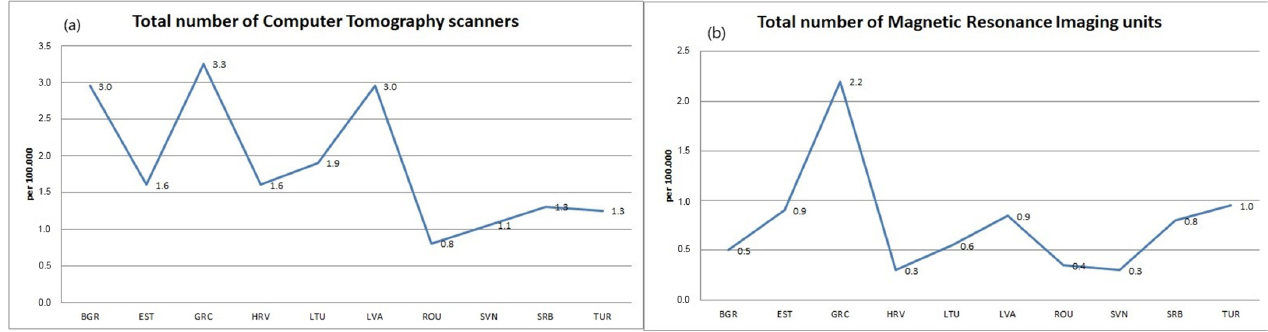
Figure 2. Median values of indicators: ( a ) total number of computed tomography scanners and ( b ) magnetic resonance imaging units per 100,000 inhabitants. Albania—ALB, Bosnia and Herze ‐